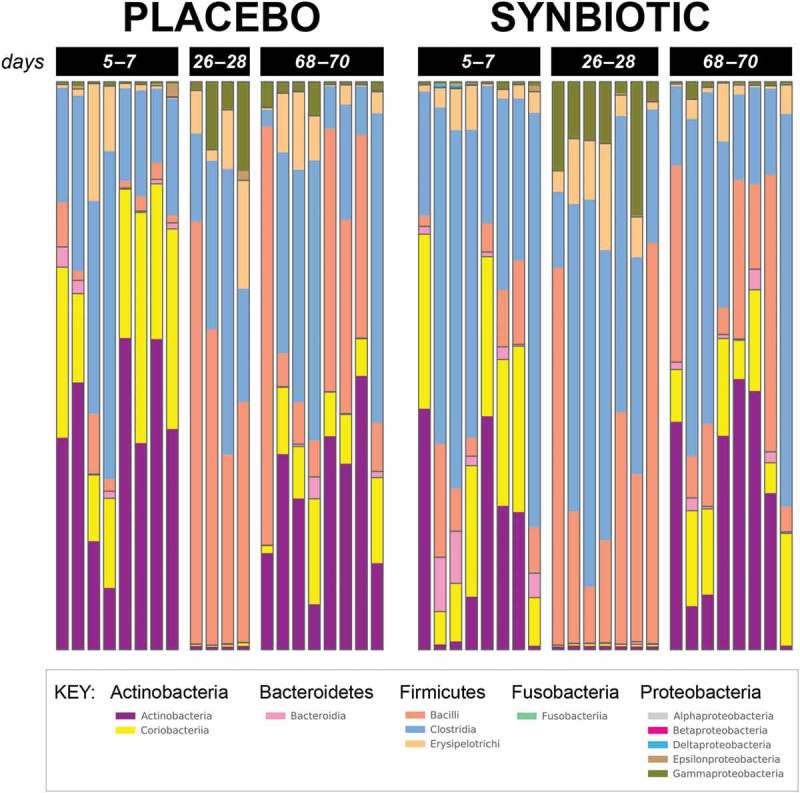
Phylum- and class-level composition of fecal microbiota obtained from feline fecal samples.Samples were collected at baseline (days 5–7), at the conclusion of antibiotic administration (days 26–28), and after a 6-week washout (days 68–70) from 16 healthy cats, 8 per group,+ that received 75 mg clindamycin followed 1 h later by either two capsules of a placebo or synbiotic PO once daily for 21 days. +Feces not available from four cats at time point 26–28 because of early termination of treatment due to severe gastrointestinal signs. Legend for all detected classes is shown, grouped by phylum.